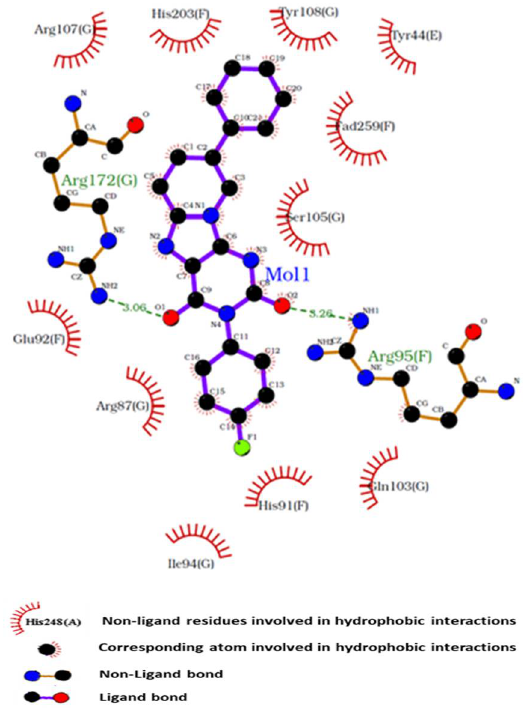
Figure 4. Hydrogen bond and hydrophobic interactions between the binding site of ThyX from Mycobacterium tuberculosis complex with FAD and 23a . The green dotted lines depict the hydrogen bonds whereas the other residues represent the hydrophobic interactions with the respective compounds.